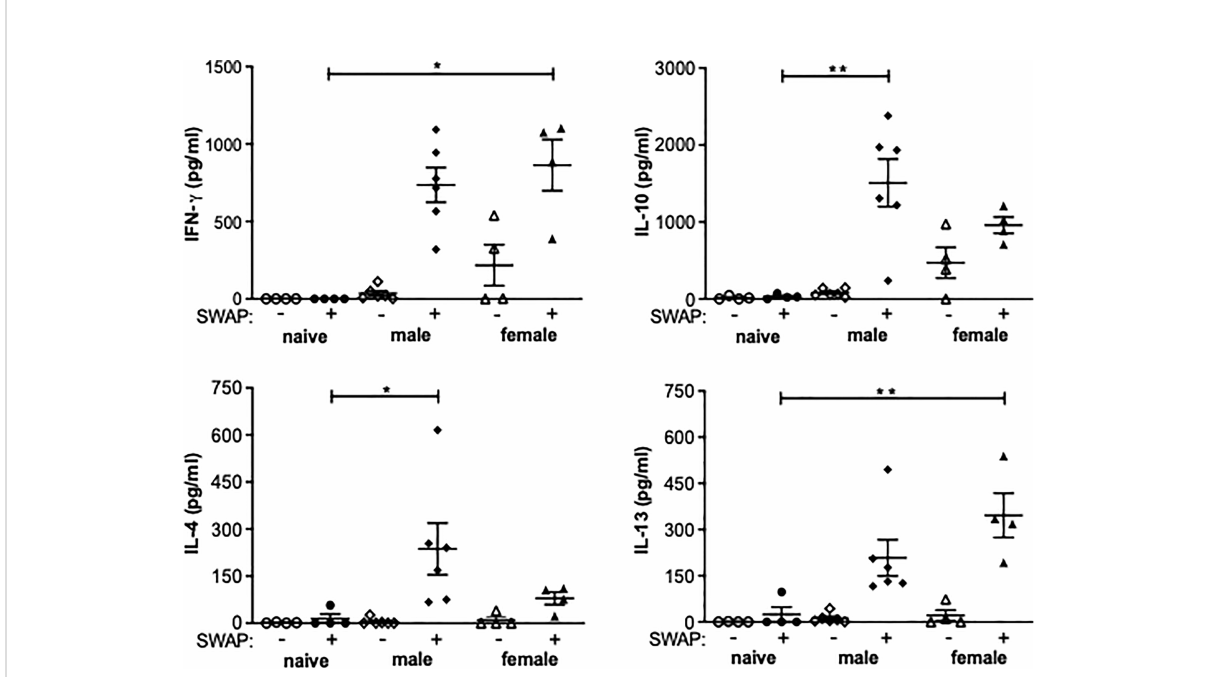
FIGURE 4 Splenocytes from unisexually infected mice produce Th1 and Th2 cytokines following SWAP stimulation. Splenocytes were isolated from unisexually male-infected, unisexually female-infected and uninfected (naive) control mice and stimulated with 10 µg/ml soluble worm antigen preparation (SWAP). Supernatants were collected after 72 hours and amounts of IFN- g , IL-4, IL-13 und IL-10 were quanti fi ed by ELISA (n=4-6). Data are presented as mean ± SEM from duplicate data. P values < 0.05 were considered statistically signi fi cant. * p < 0.05, ** p < 0.01.